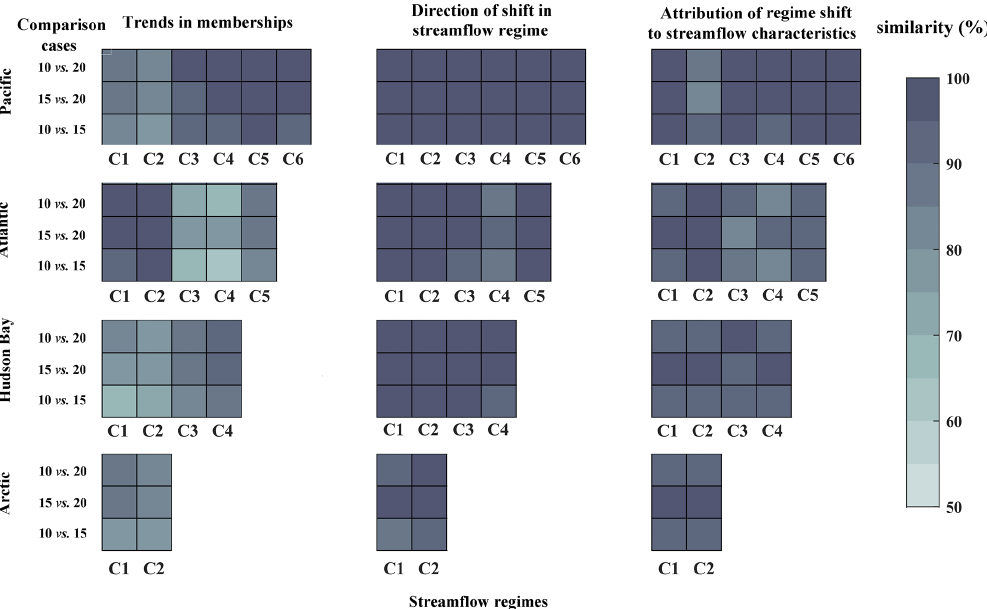
Figure 11. Similarities (in percentage) between the results obtained by 10-, 15-, and 20-year timeframes related to trends in membership values, direction of shift in streamflow regimes, and attribution to streamflow characteristics in the four major Canadian